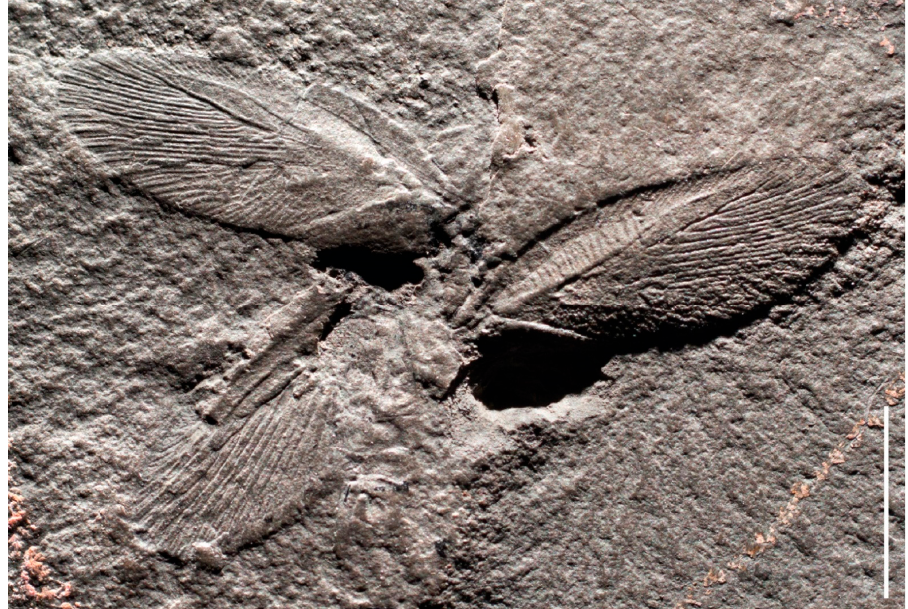
Figure 3. Glaphyrophlebia pygmaea (Meunier, 1907), holotype MNHN.F.R51519, Gzhelian of Com- mentry, France. Photograph credits MNHN Gaëlle Doitteau, 2016. Scale bar = 5 mm. Glaphyrophlebia wettinensis [20] (Gzhelian of Germany, recently attributed to this ge- nus [18]) is also not listed nor keyed in Aristov et al. [8]. It also has a vein bow between RA and CuA, no well-defined anterior branch of CuA, and a straight ScP, unlike the new fossil [18,21]. Additionally, the anterior branch of M is forked close to the first dichotomy of M, while simple or forked far distad the first dichotomy of M in G. wettinensis [18]. Glaphyrophlebia delicatula (Bolton, 1934, Moscovian, 314.6 Ma, South Wales, UK, re- cently attributed to this genus [18]) is also not listed nor keyed in Aristov et al. [8]. It is based on a very incomplete fragment of forewing. Bolton [22] did not indicate the presence of longitudinal furrows between branches of RP and M, and these are not visible in the photograph of the holotype. Therefore, the placement and attribution of the species to the genus Glaphyrophlebia is highly uncertain. Based on the detailed comparison provided above, the new fossil represents a new species of the genus Glaphyrophlebia , and it is, therefore, the third one from the Carbonif- erous confidently placed in this genus. Glaphyrophlebia sp. Figure 4A